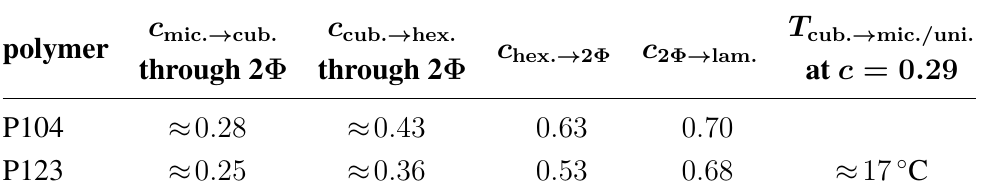
Table 1. Phase transition temperatures and concentrations of studied samples at 25 ◦